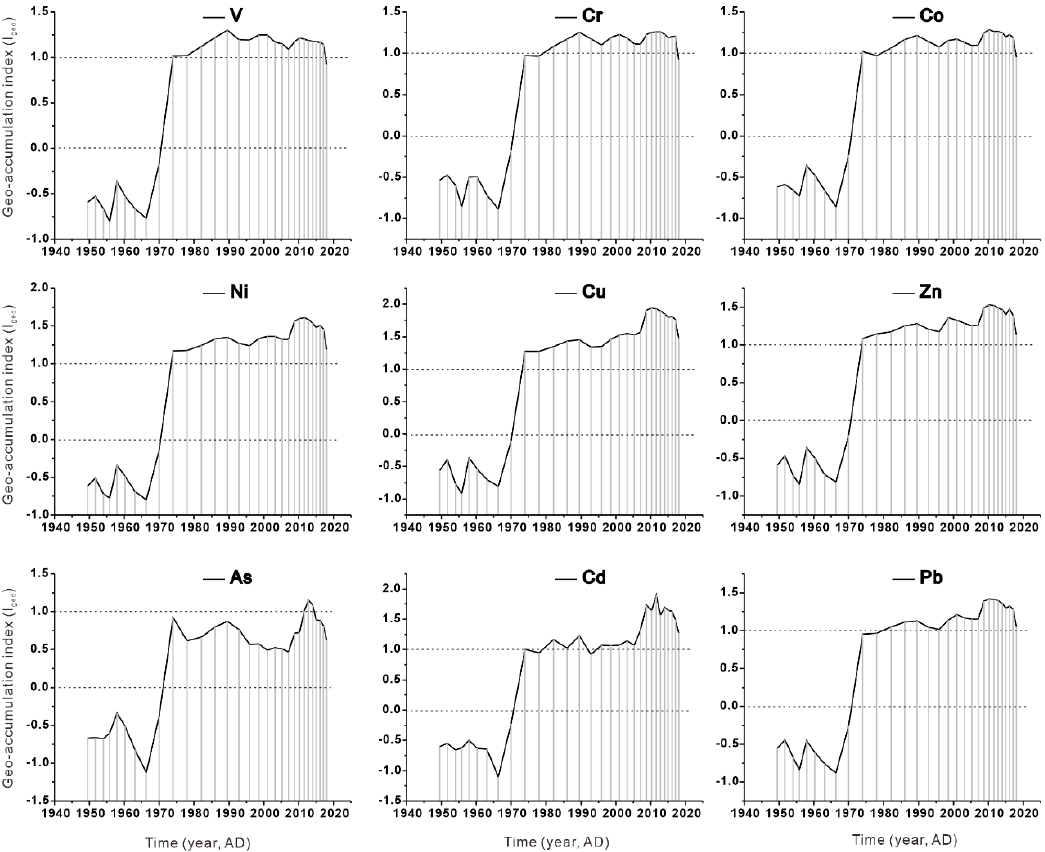
Figure 4. Time-varying curves of PTE geo-accumulation indexes (I geo ).